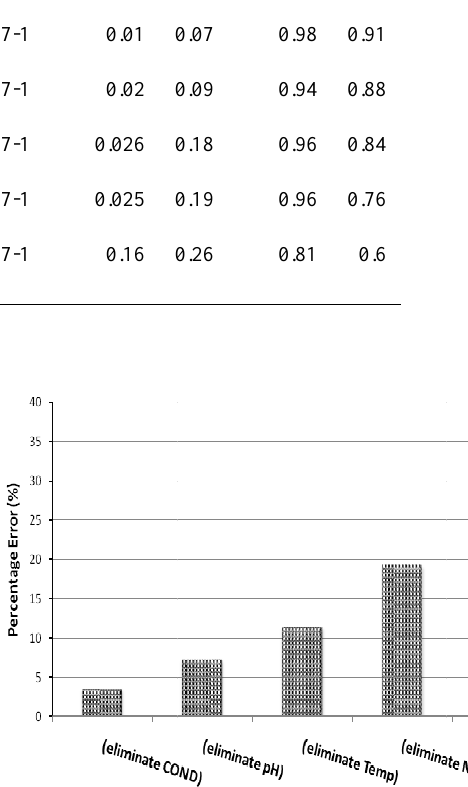
for validation (in Fig. 8. A scatter diagram of the predicted versus observed DO for Fig. 9: Percentage error of the model Fig. 9: Percentage error of the model if any one of the input parameters any one of the input parameters was Fig. 9. Percentage error of the model if any one of the input param- removed eters was